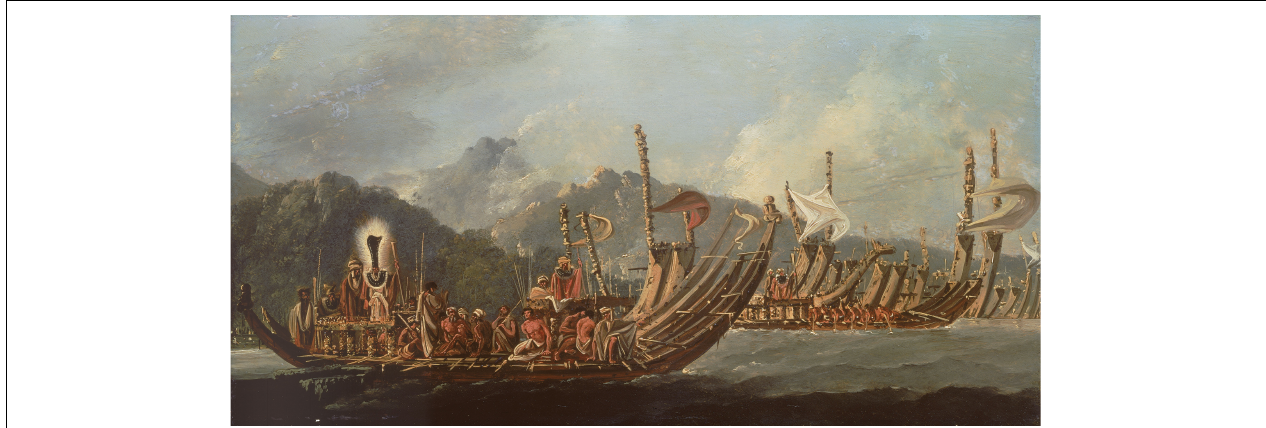
FIGURE 4 | Engraving of large double-hulled canoes amassed on the coast of Tahiti waiting to launch and wage war on Mo‘orea. “The Fleet of Otaheite assembled at Oparee,” 1776. Artist William Hodges, courtesy of National Maritime Museum, Greenwich, London (BHC2395).